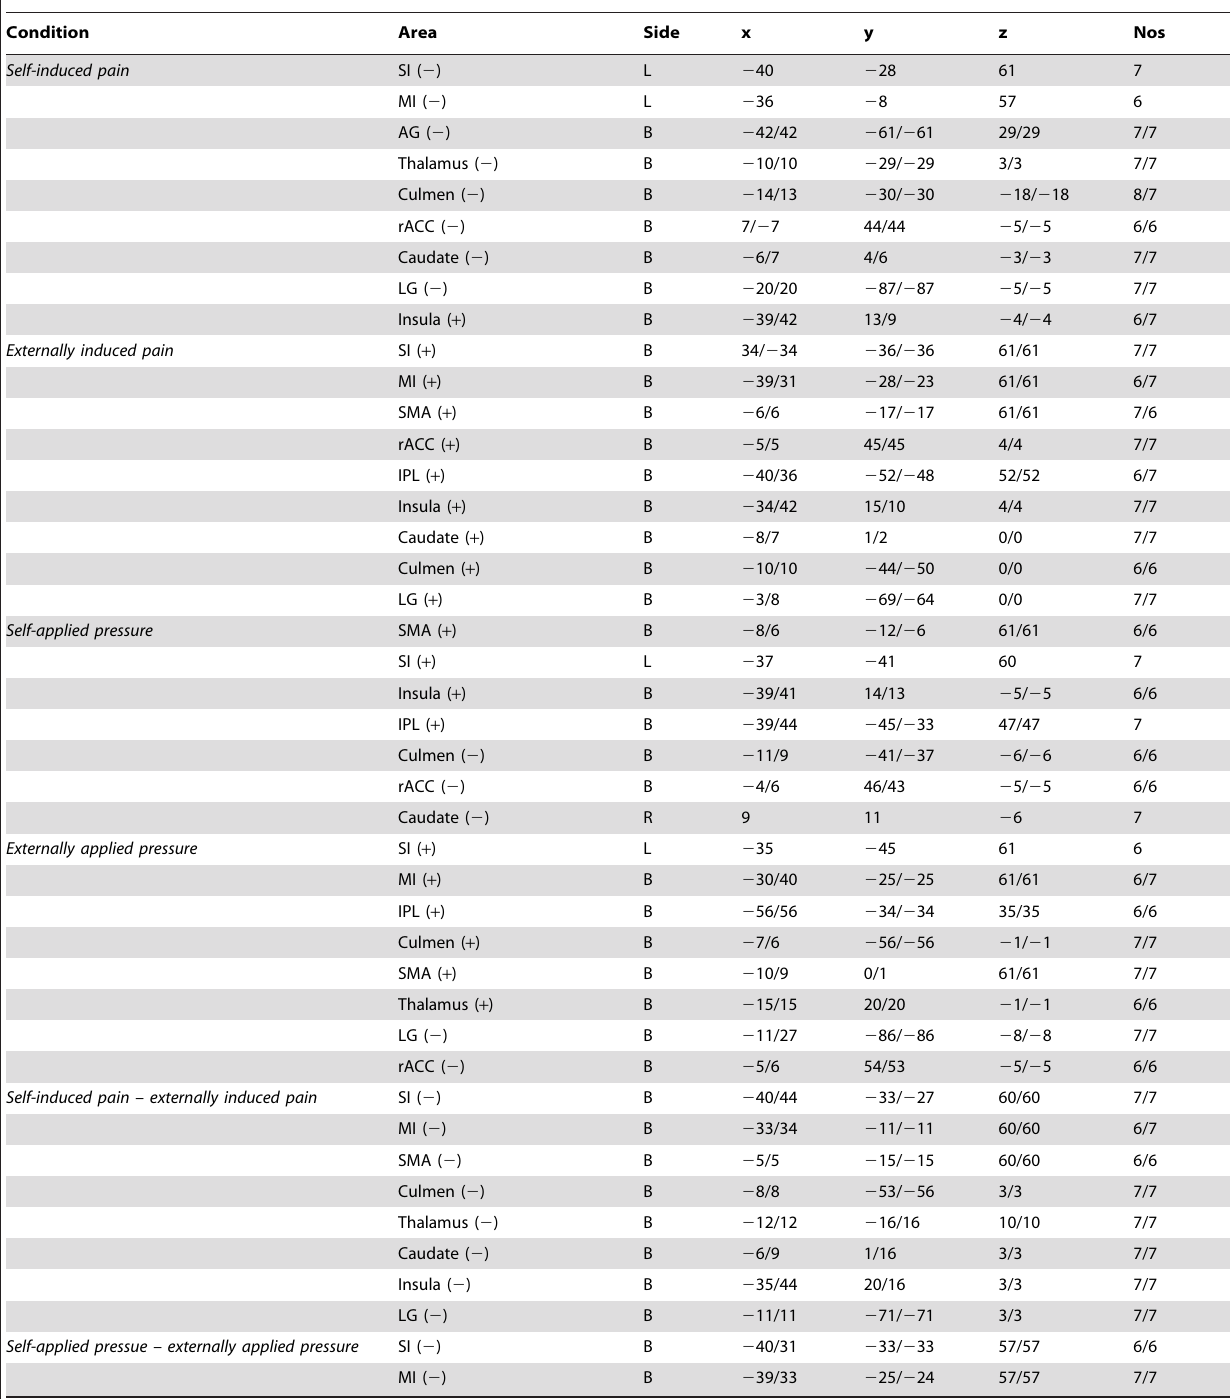
Table 1. Brain areas affected by each condition.